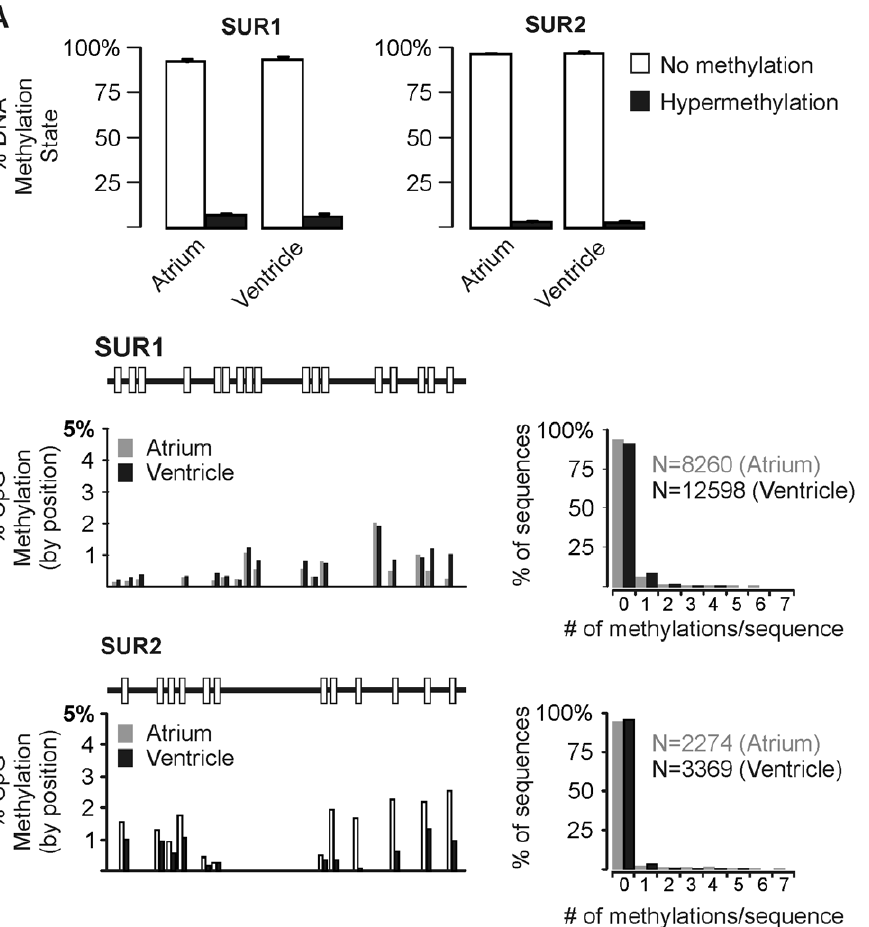
Figure 6. Chamber-specific SUR1 and SUR2 expression does not correlate with CpG island methylation. Total CpG island methylation of SUR1 and SUR2 as measured using either (A) EpiTect assay or (B) bisulfite sequencing. Using either method, SUR1 and SUR2 CpG islands were predominantly unmethylated in both atrial and ventricular genomic DNA. In panel B, CpG methylation is analyzed in a position-specific (left) and whole sequence-specific manner (right). No CpG residue was methylated in more than about 2% of all sequences